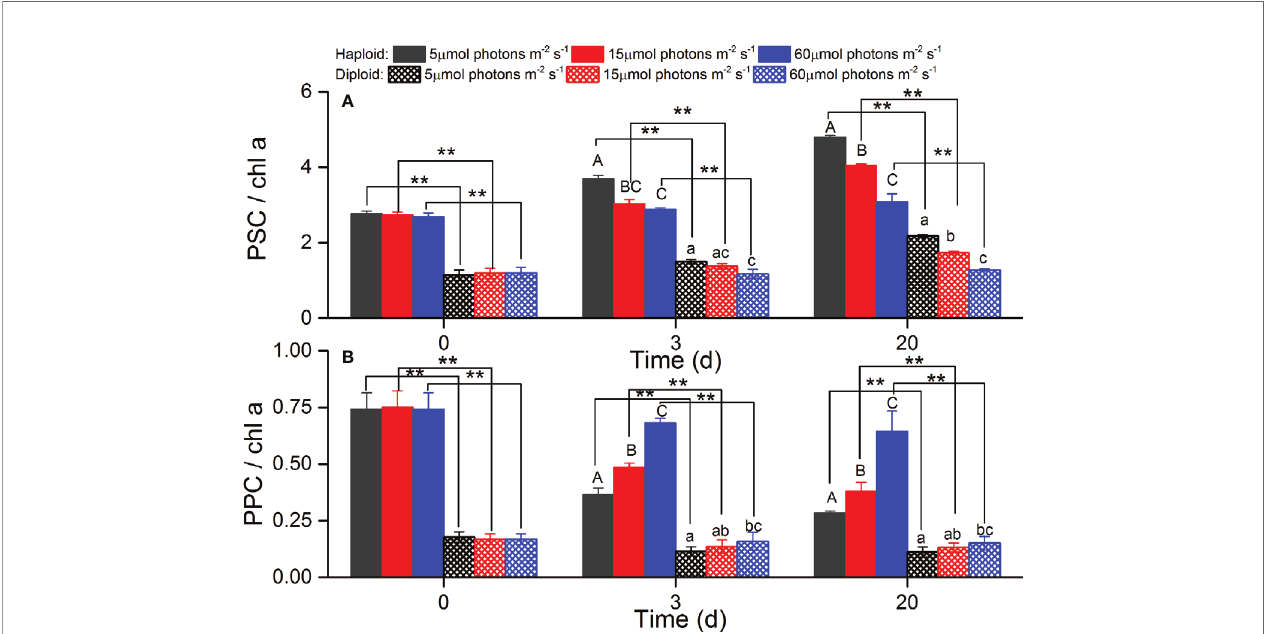
FIGURE 8 | Averages of photosynthetic pigment (PSC, A ) and photoprotective pigment (PPC, B ) contents for haploid and diploid solitary cells of P. globosa under different light intensities at day 0, day 3 and day 20. Data are normalized to the Chl a content. ** indicates a signi fi cant difference (p < 0.01) between haploid and diploid solitary cells on the same day. Different uppercase and lowercase letters indicate signi fi cant differences among the three light intensities for haploid and diploid solitary cells,